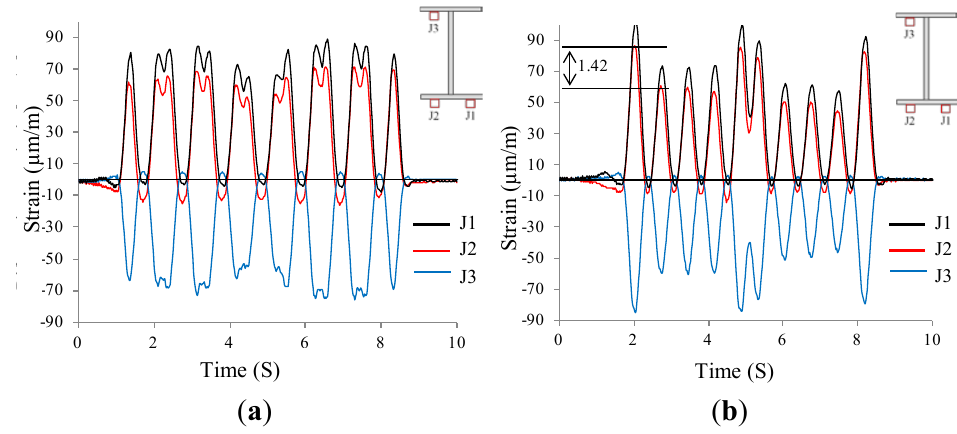
Figure 12. Strain measured at different locations of fourth cross-beam of Münchenstein Bridge while ( a ) ICN train; and ( b ) S3 train passes across the bridge.